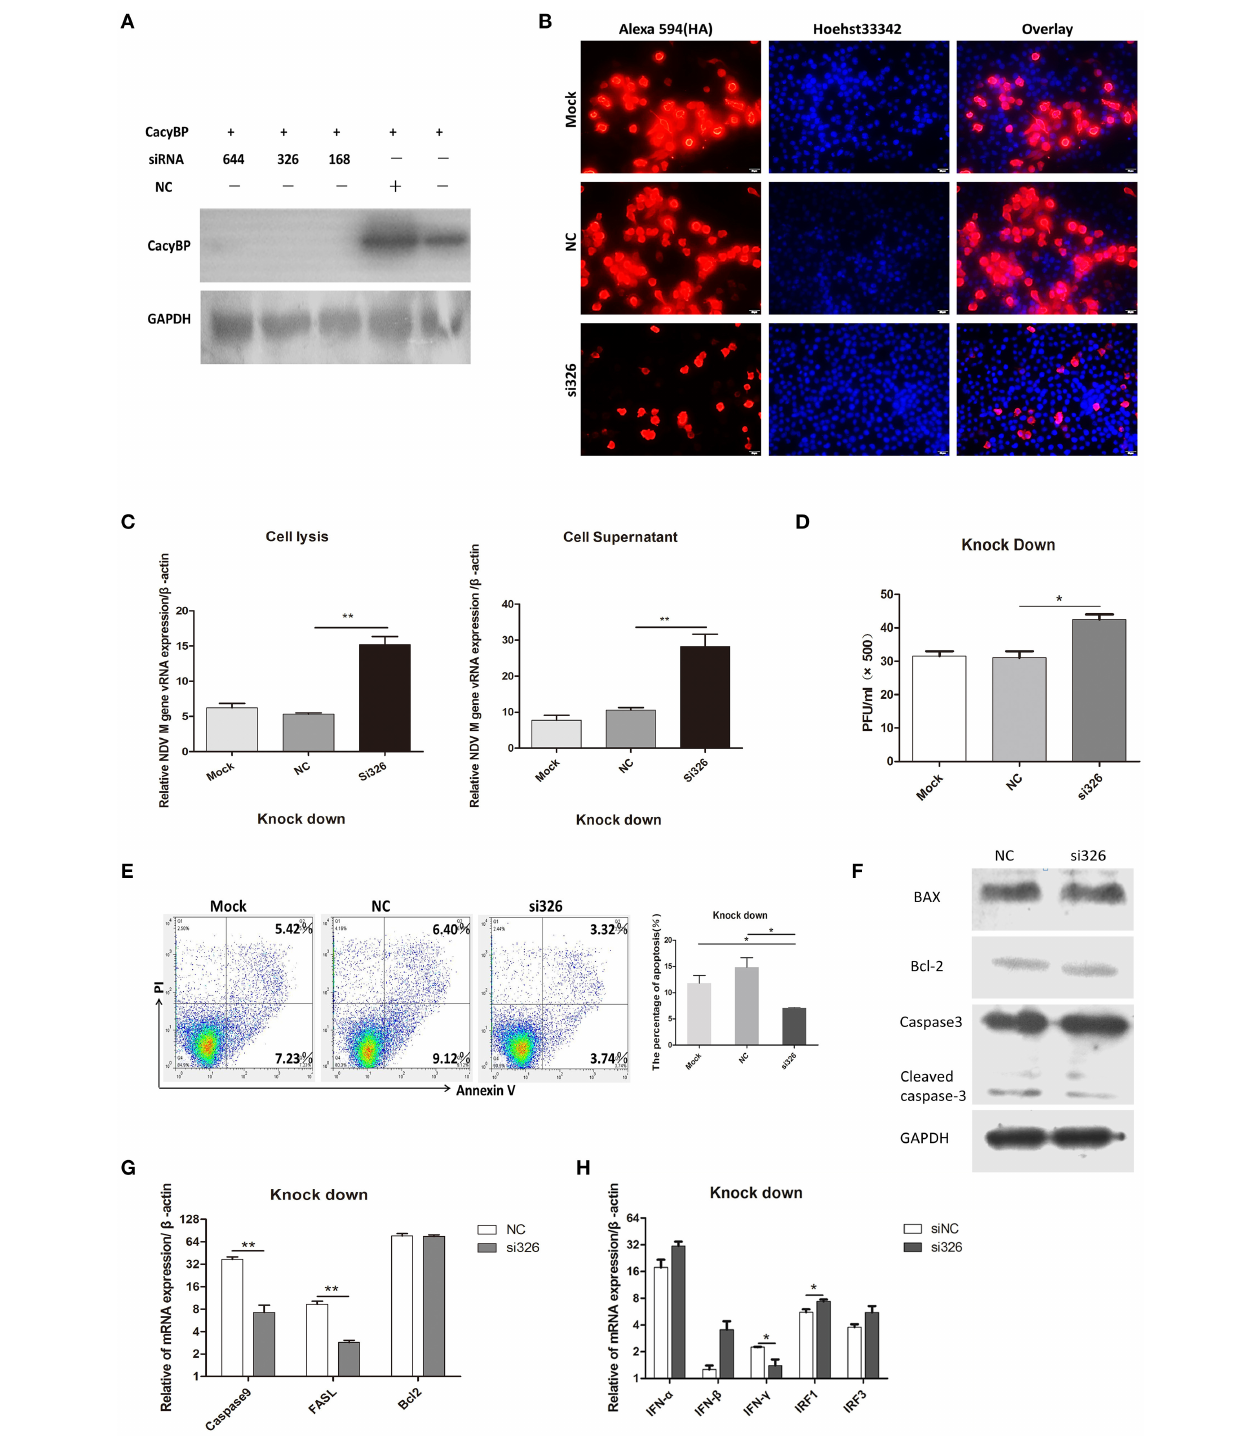
FIGURE 4 | Knockdown of CacyBP facilitated viral replication and arrested apoptosis in DF-1 cells. DF-1 cells were transfected with mock and/or NC and si-CacyBP/SIP and incubated for 36h. Mock, treated with transfection regent; NC, transfected with si-NC; si183/326/644, separately transfected with those siRNAs targets CacyBP/SIP. (A) Endogenous CacyBP/SIP was detected by western blotting. (B) DF-1 cells were co-transfected with si-CacyBP (326) and pCMV-HA-CacyBP. Thirty-six hours after transfection, protein expression of HA-CacyBP was detected by anti-HA antibody through immunofluorescence in DF-1 cells. (C) Replication kinetics of NDV RNAs from the mock, NC, and siRNA (326) groups of DF-1 cells; 1 MOI of F48E9 NDV were inoculated into the three groups of